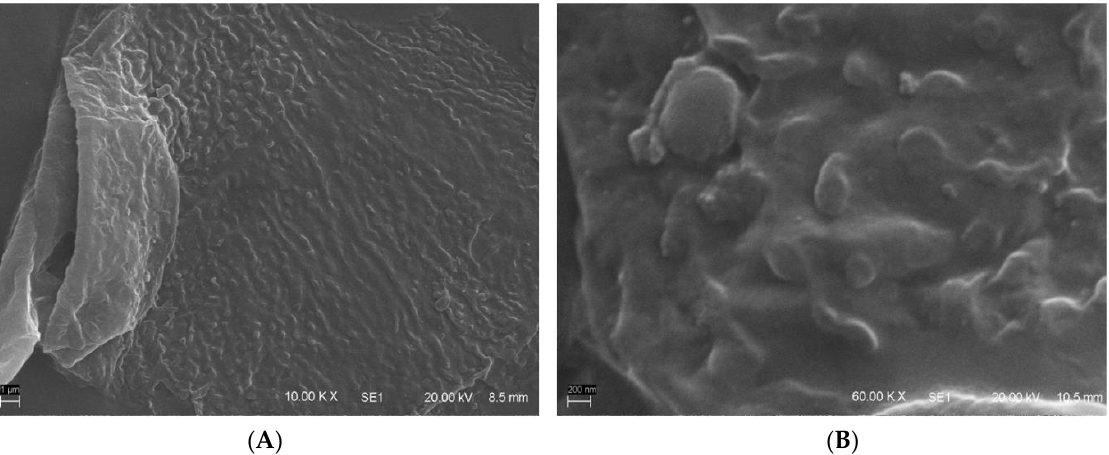
Figure 1. Scanning electron micrographs of 1 mg/mL KDP-loaded nanoemulsion (NERO1KDP) at ( A ) 10,000× and ( B ) 60,000× magnification. Table 1. Characterization of unloaded nanoemulsion (NERO), 1 mg/mL kojic dipalmitate (KDP)- loaded nanoemulsion (NERO1KDP), and 2 mg/mL KDP-loaded nanoemulsion